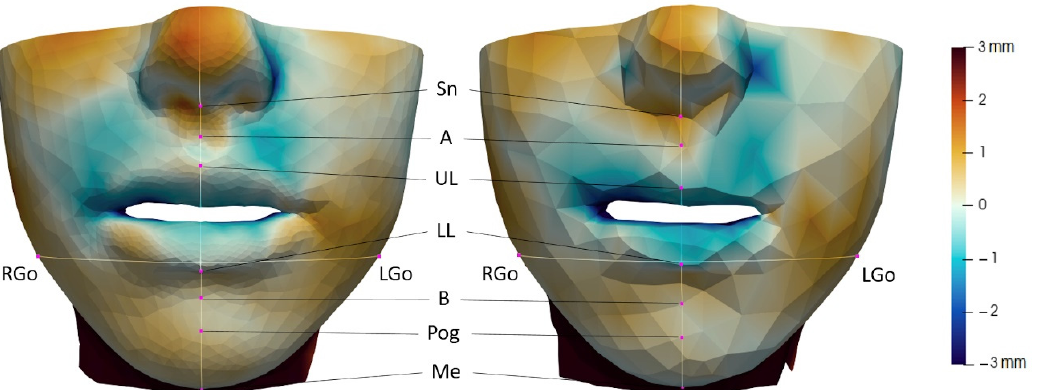
Figure 2. Anatomical landmarks where the distance to the actual surgical outcome was measured for the soft tissue fine mesh (left) and coarse mesh (right).